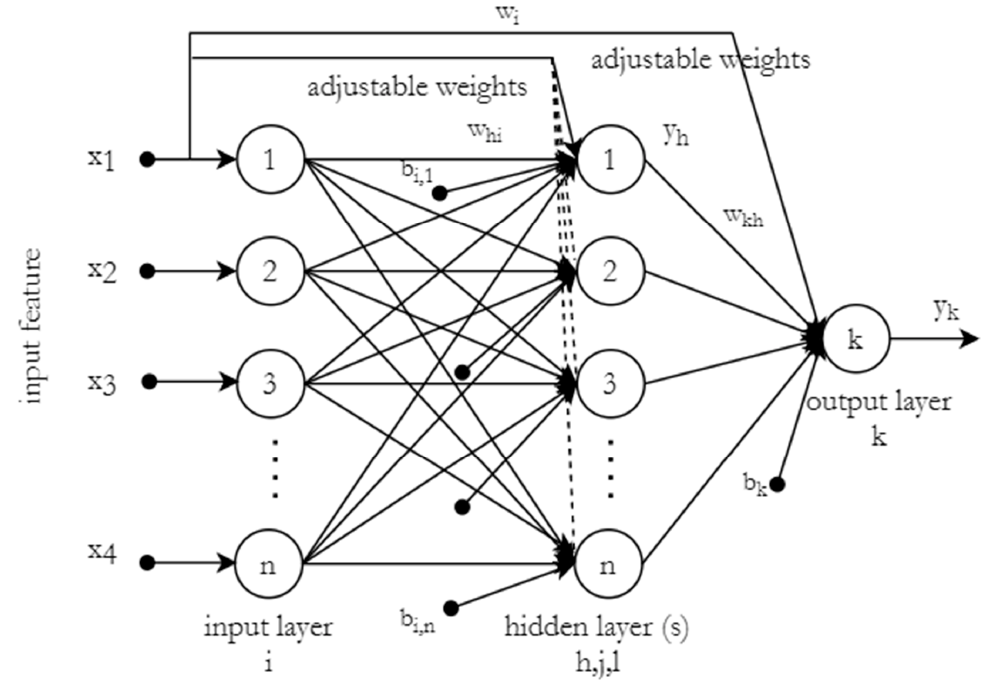
Figure 2. Illustration of the cascade-forward neural network (CFNN) structure used in this study